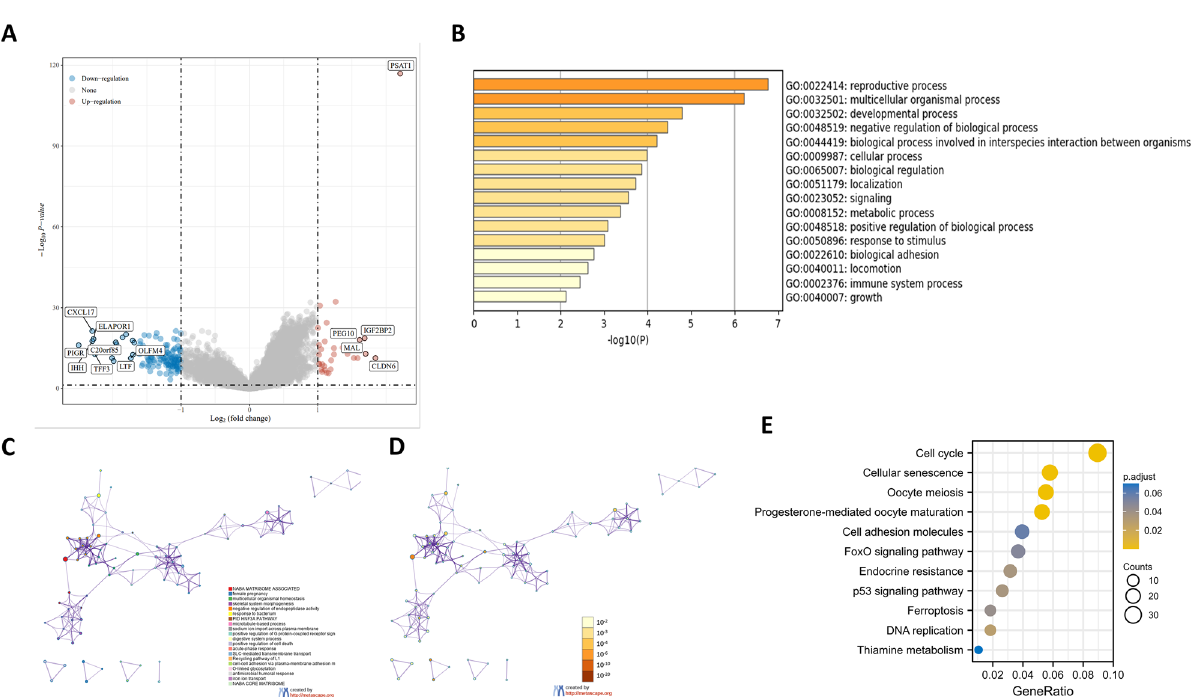
Figure 4. DEGs and enrichment analysis. ( A ) Volcano Plot of differentially expressed genes (DEGs). ( B – D ) GO enrichment analysis performed by the Metascape database 2.0. ( E ) KEGG enrichment analysis to identify the key pathways related to PSAT1 in